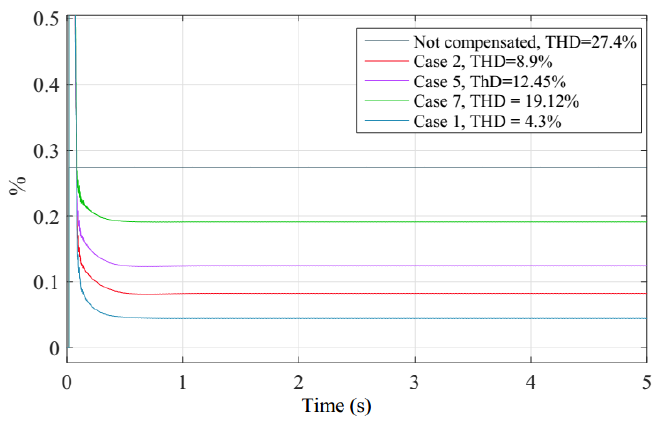
Figure 18. Harmonic distortion for Cases 1, 2, 5 and 7 from Table 2 and grid current without